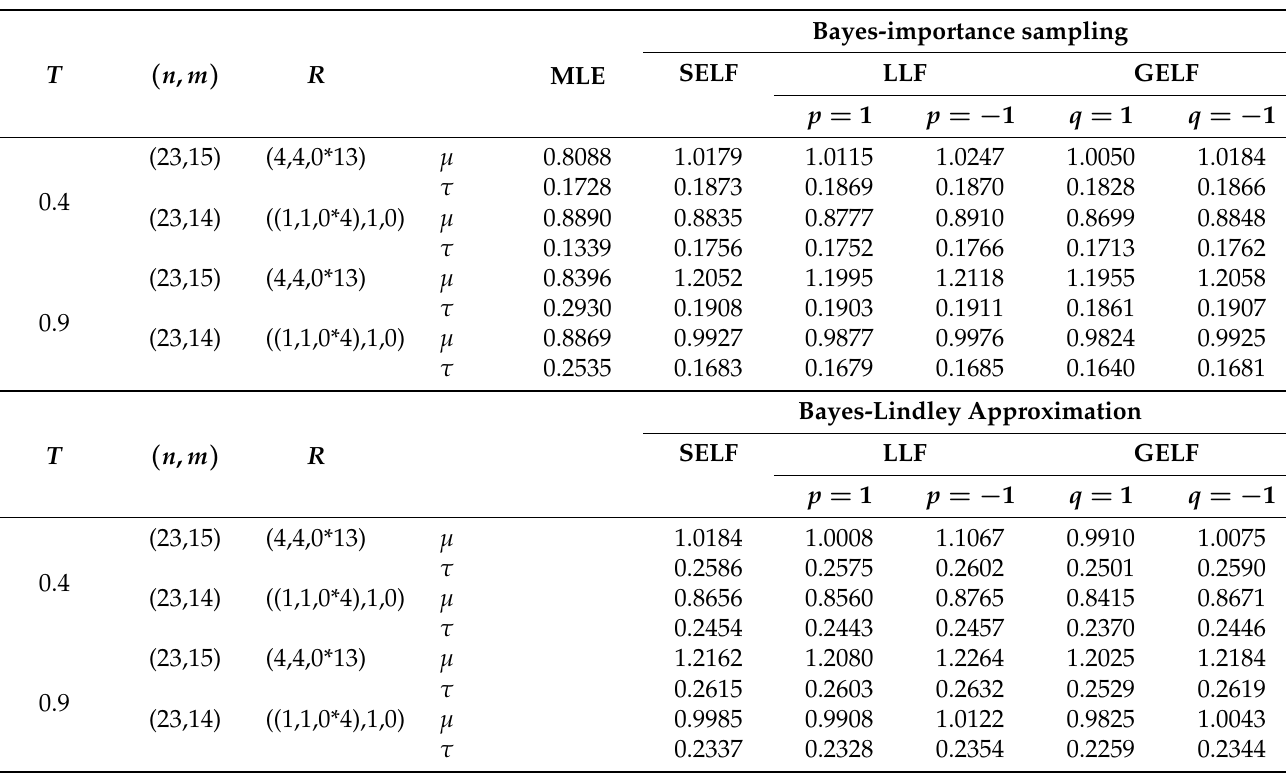
Table 6. Point estimations based on the real data set.